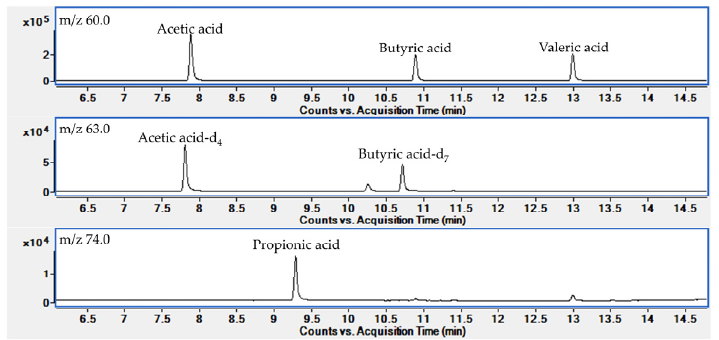
Figure A1. SIM chromatograms of SCFA standard mixture dissolved in water.